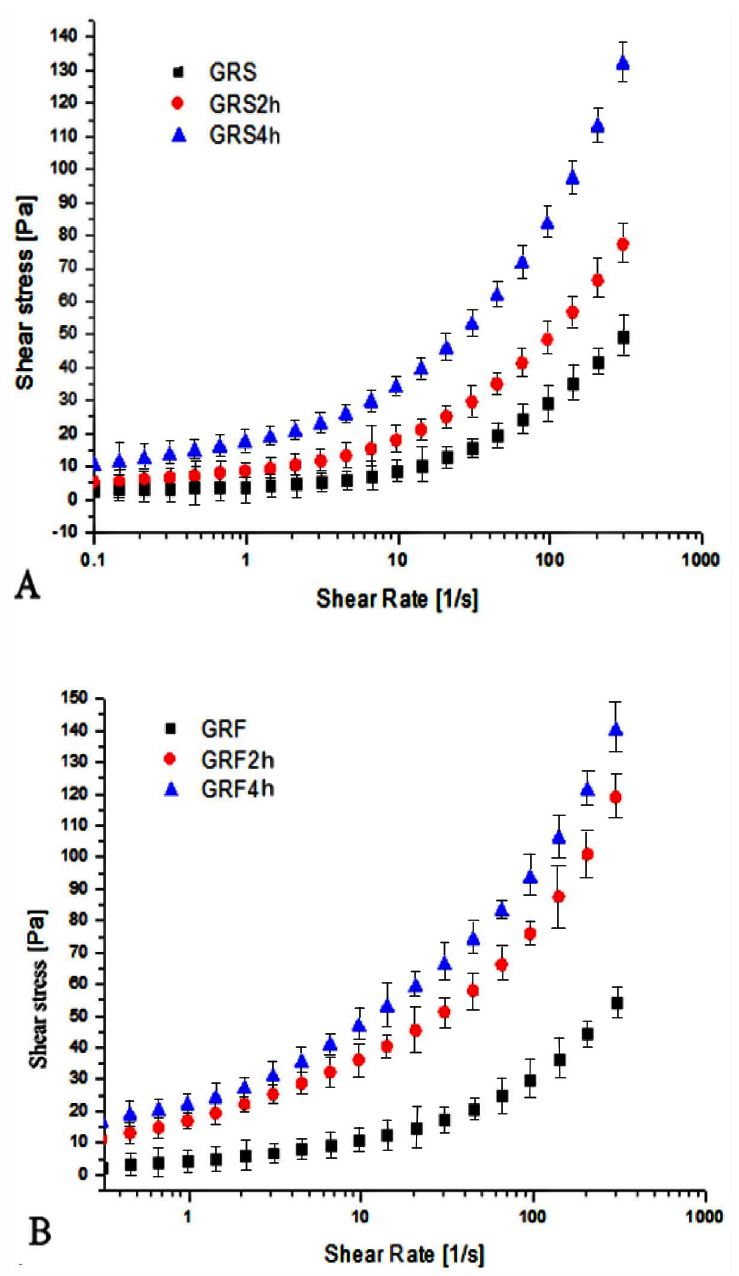
Fig 3. Relationship between shearing stress and shearing rate of GRS (A) and GRF (B) before and after dry heating. GRS2 h, 4 h: the glutinous rice starch (GRS) pastes after dry-heat treatment at 130°C for 2, 4 h; GRF2 h, 4 h: the glutinous rice flour (GRF) pastes after dry-heat treatment at 130°C for 2, 4 h. The data points represent the mean values of three samples and error bars show the standard deviation. highest value when the samples were heated for 4 h. The K value of GRS increased from 18.23 Pa (cid:3) s n to 37.71 Pa (cid:3) s n , and that of GRF increased from 20.77 Pa (cid:3) s n to 64.34 Pa (cid:3) s n (Table 3), indi- cating dry-heat treatment increased interactions between starch molecules in GRS, between starch and protein, or between protein and protein in GRF. The magnitude of K value